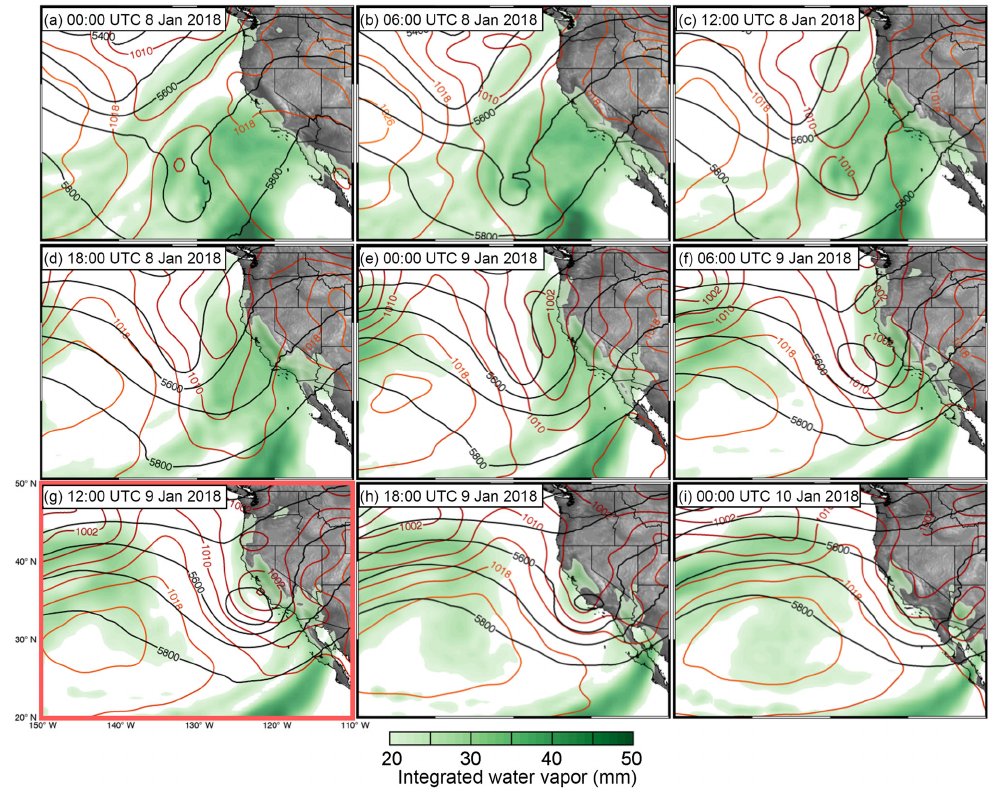
Figure 2. The 500hPa geopotential heights (black contour lines), sea level pressure (hPa; pink contour lines), and integrated water vapor (IWV; green filled contours) at 6h intervals for 36h preceding the event, the time nearest the event (outlined in pink), and 12h following the event. Analysis based on Climate Forecast System version 2 operational analysis (Saha et al., 2014; https://www.ncdc.noaa.gov/data-access/ model-data/model-datasets/climate-forecast-system-version2-cfsv2; last access: 5 November